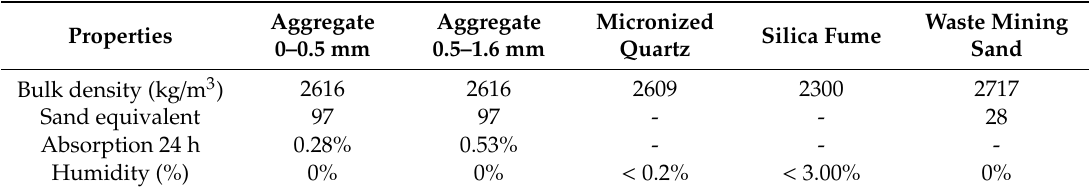
Table 1. Properties of the materials.